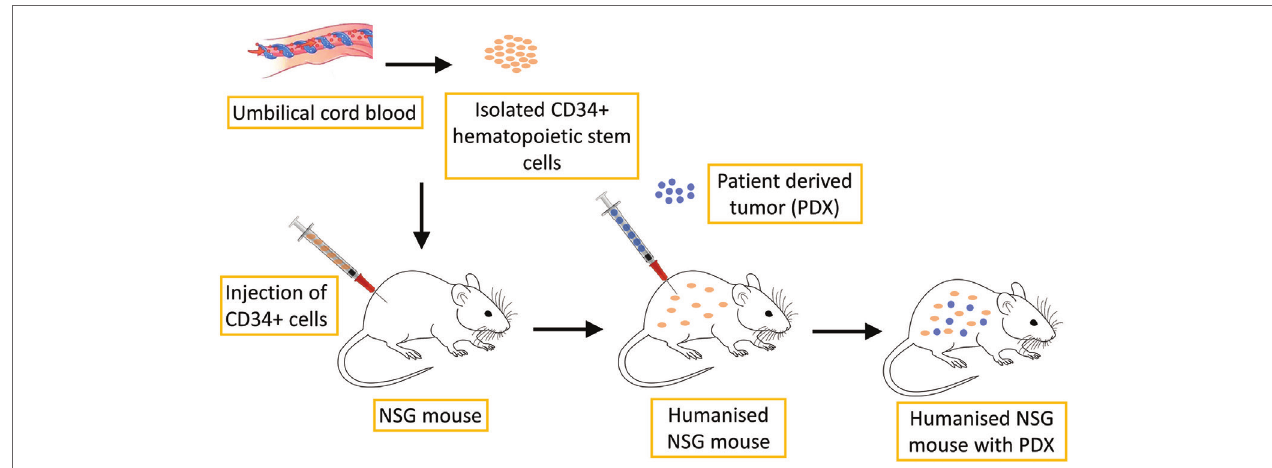
FiGURe 4 | Schematic illustration of humanized PDX mouse model production. CD34 + human hematopoietic stem cells, which are isolated from umbilical cord blood, are transplanted into NSG mice. This process leads to the development of human hematopoietic and immune systems. PDX of various tumors can then be implanted for further